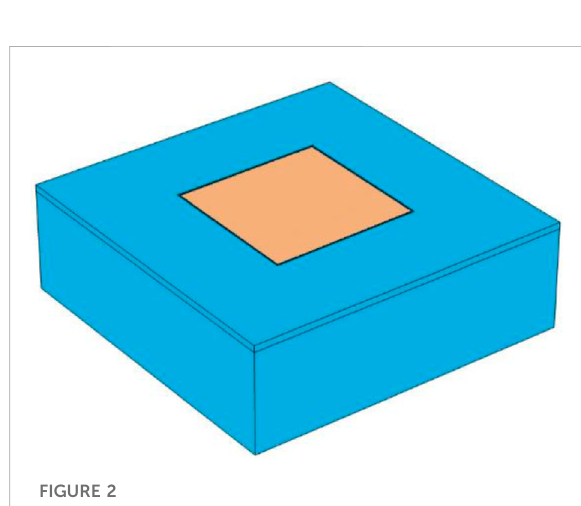
FIGURE 2 The overall appearance of the sensor